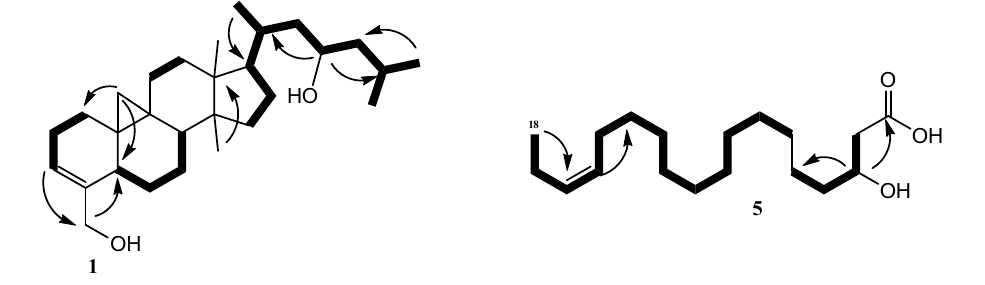
Figure 2: Selected 1 H – 1 H COSY ( ▬ ) and HMBC ( ) correlations of compounds 1 and 5